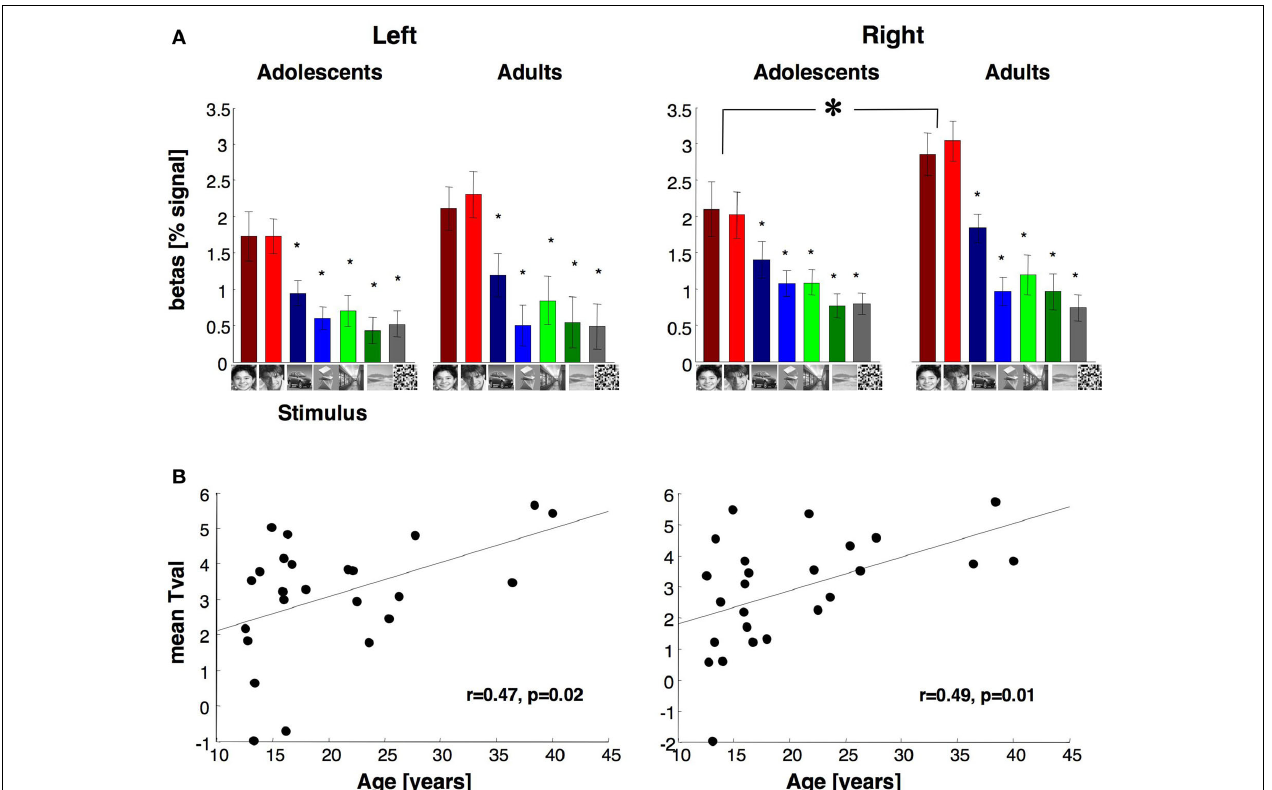
FIGURE 5 | Average response to different stimuli and face selectivity within face selective regions of fusiform gyrus. (A) Average responses to different image categories (relative to the blank baseline) of face selective voxels during run 2. Data are averaged across 14 adolescents and 11 adults in the right hemisphere and 13 adolescents and 11 adults in the left hemisphere. Face selective voxels were independently defi ned using run 1 data with the contrast: man and boy > cars and abstract objects, P < 10 –3 , uncorrected. Error bars